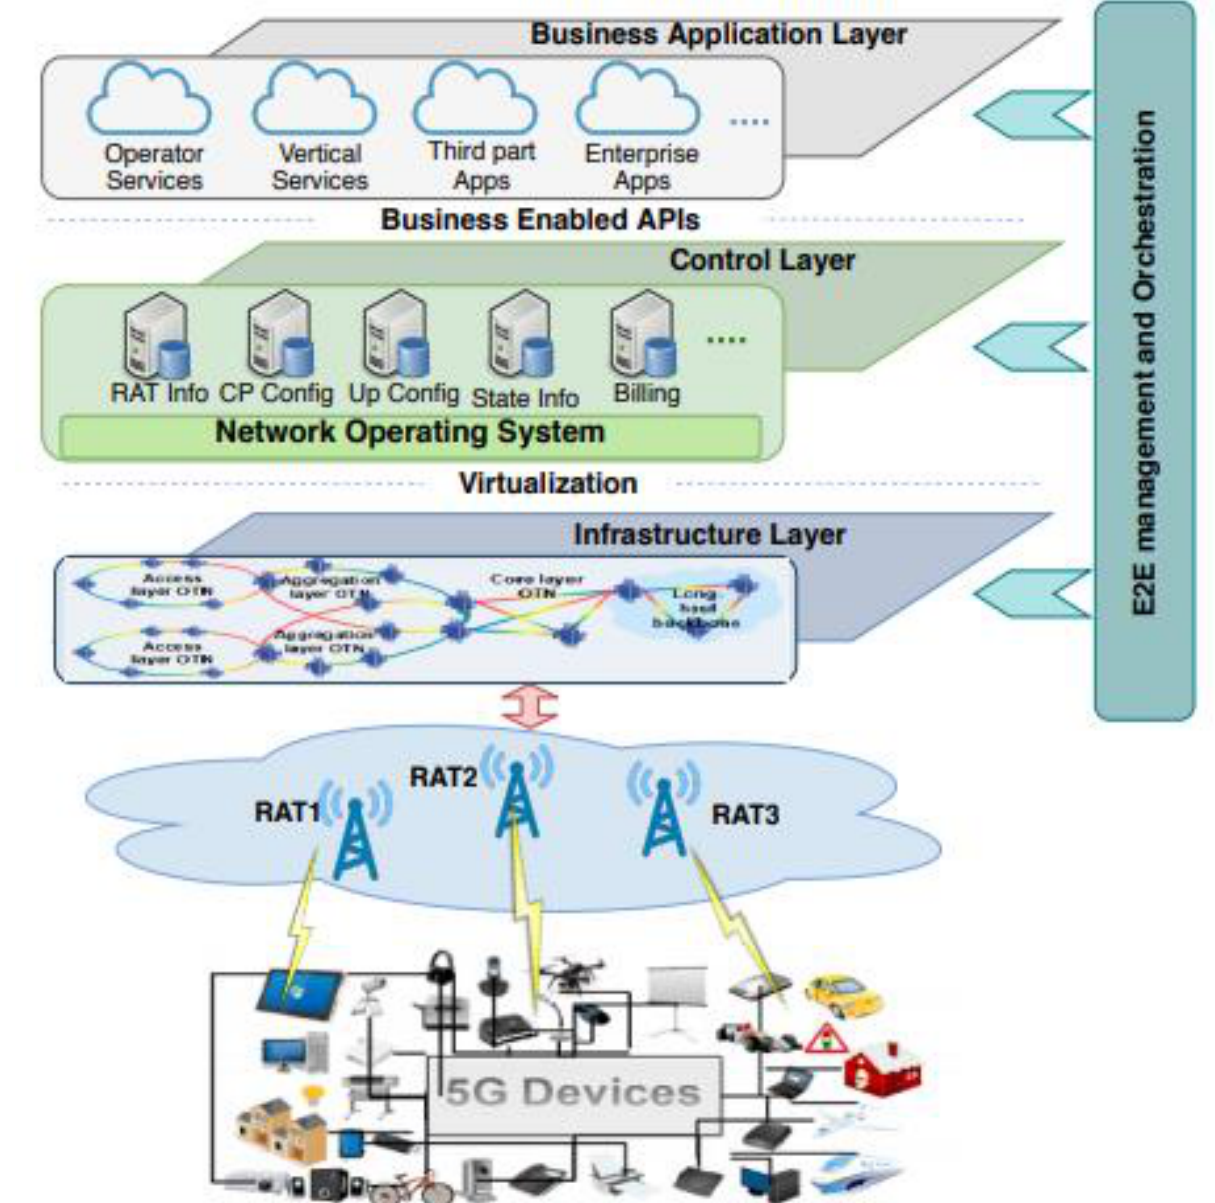
Figure 2. A 5g network top-level architecture with a different operating